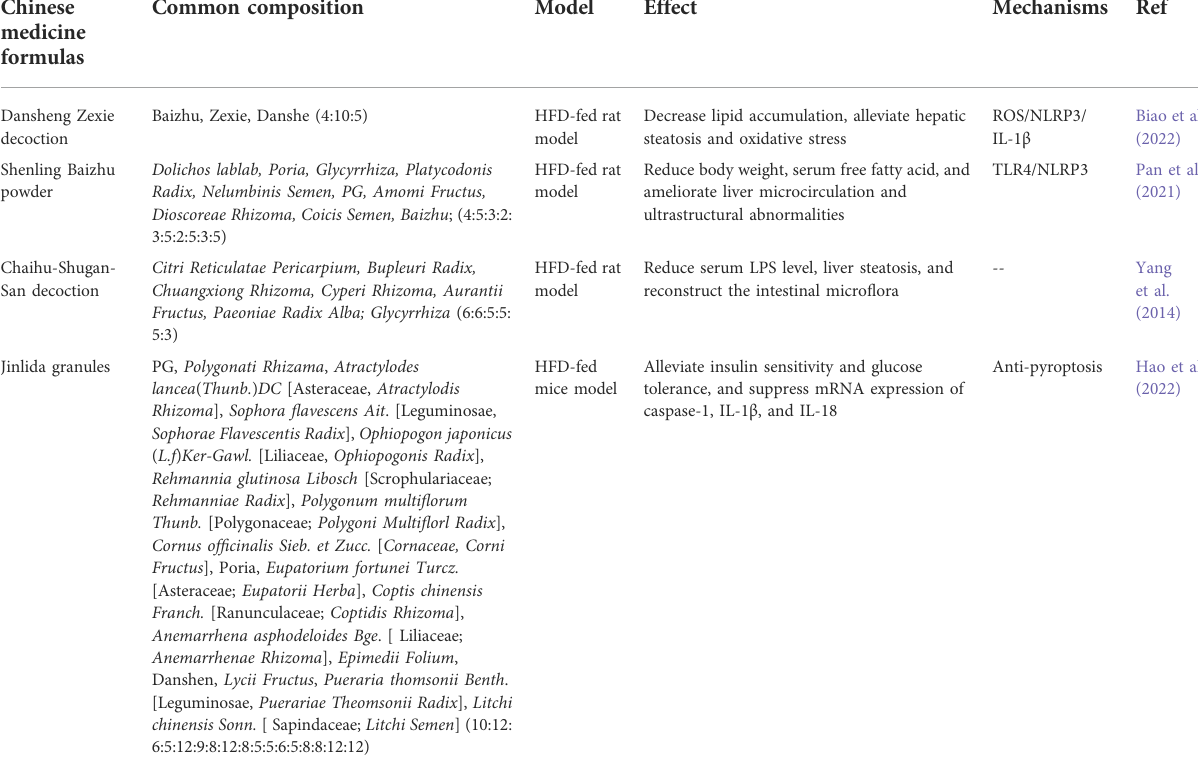
TABLE 3 Traditional Chinese medicine formulas for the treatment of FLD by inhibiting NLRP3 in fl ammasome activation. Chinese